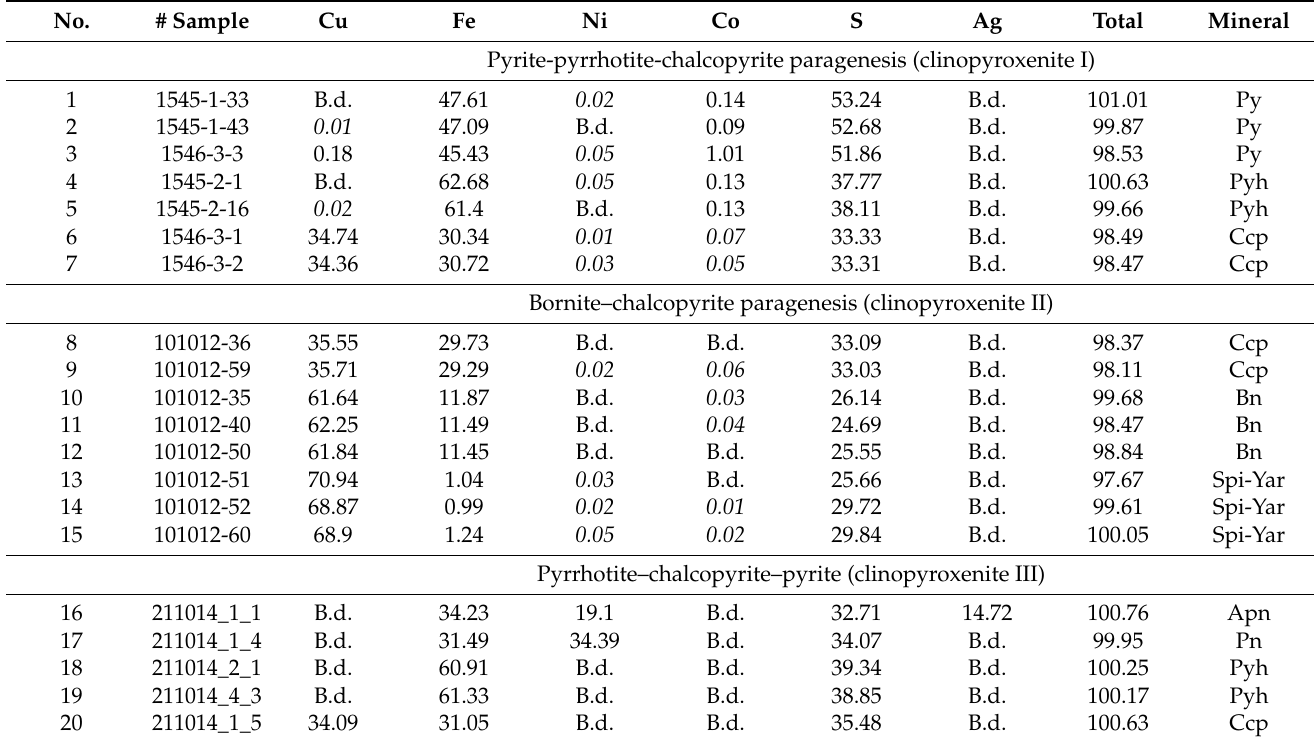
Table 9. Chemical composition of sulfides in clinopyroxenites I–III (in